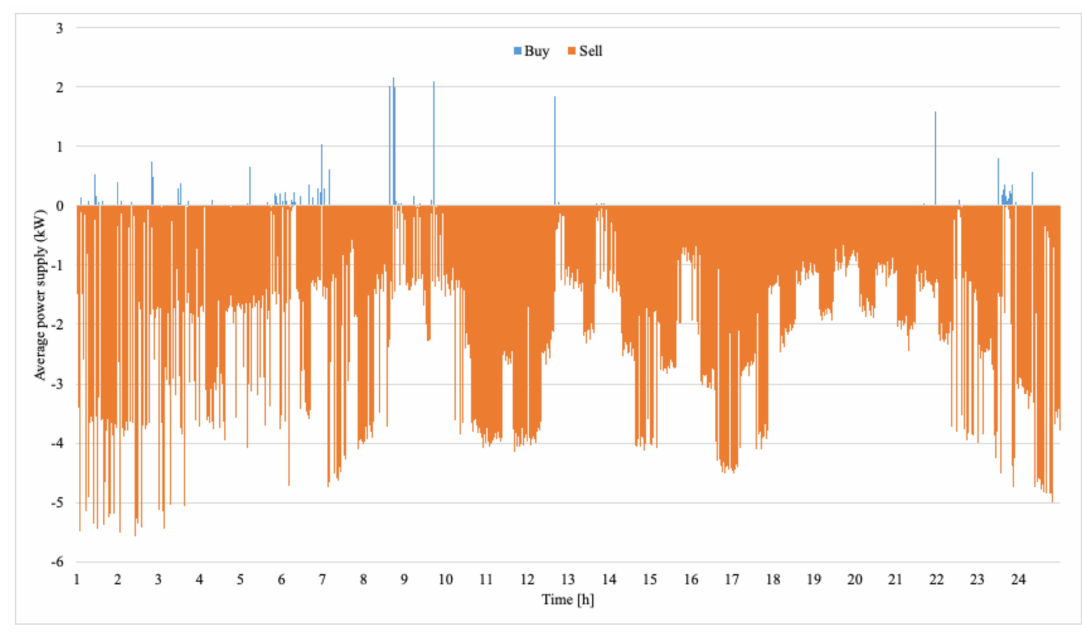
Figure 11. Trading profile of user 1.